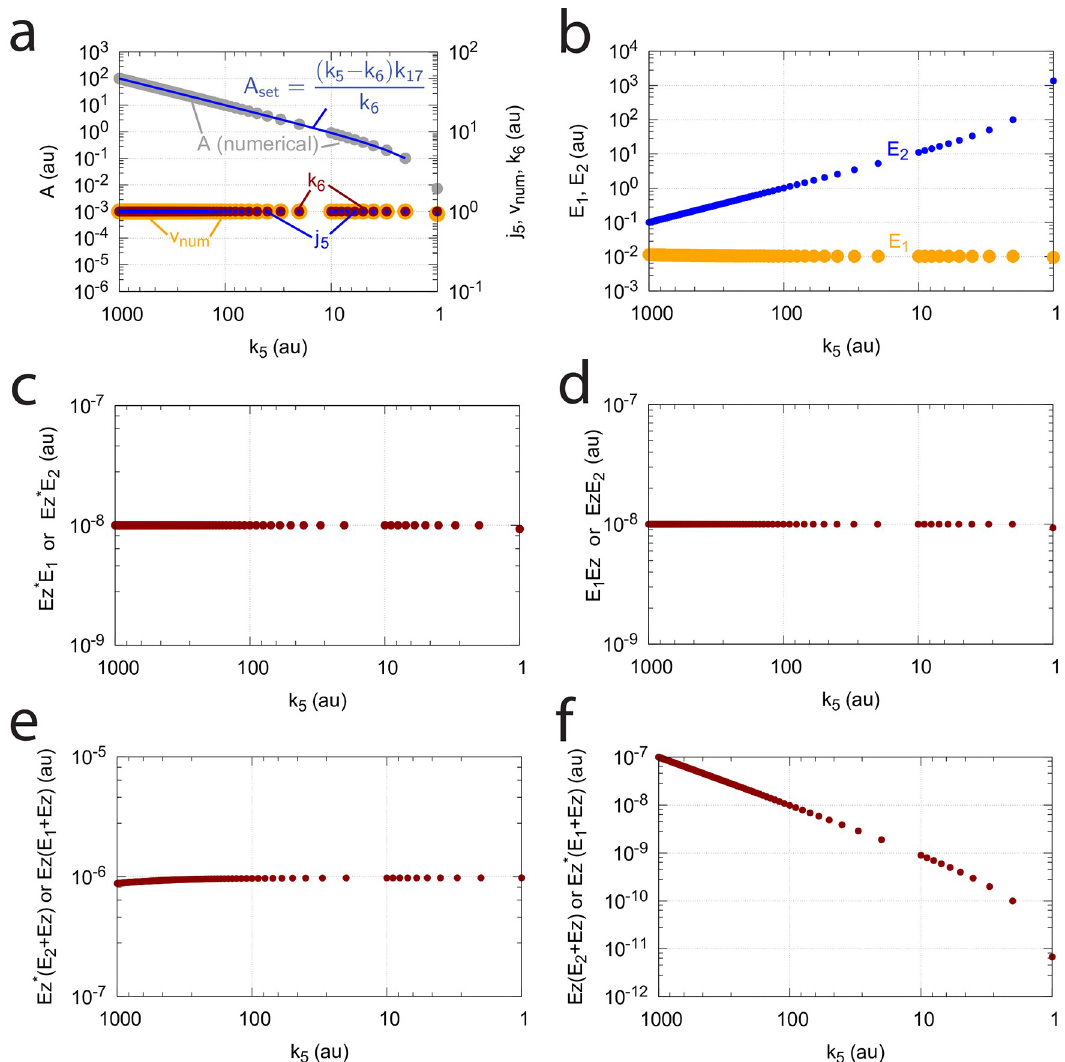
Fig 63. Concentration profiles of reaction species of the two m7 ping-pong mechanisms (Fig 59) as a function of k 5 . (a) Left ordinate: Numerical steady state values of A (gray dots) in comparison with the theoretical set-point A (Eq 160, blue line). set Ordinate to the right: k 6 (red dots), steady state values of j 5 = k 5 k 17 /( k 17 + A ) (blue dots), and numerically calculated reaction rate v num = dP / dt (orange dots). (b) Steady state values of E 1 (orange dots) and E 2 (blue dots). (c) Steady state profiles of Ez � E 2 (Fig 59a) or Ez � E 1 (Fig 59b). (d) Steady state profiles of E 1 Ez (Fig 59a) or EzE 2 (Fig 59b). (e) Steady state profile of Ez when E 1 binds first to it (Fig 59a) or profile for Ez � when E 2 binds first to Ez (Fig 59b). (f) Steady state profile of Ez when E 2 binds first to Ez (Fig 59b) or profile for Ez � when E 1 binds first to Ez (Fig 59a). Rate constants: k 1 =100.0, other rate constants as in Fig 62. Initial concentrations (a)-(f): A 0 =3.0, E 1,0 =1.0 × 10 − 2 , E 2,0 =3.0 × 10 2 , Ez 0 =1.0 × 10 − 6 , (E 1 � Ez) 0 = Ez � =(Ez � � E 2 ) 0 0